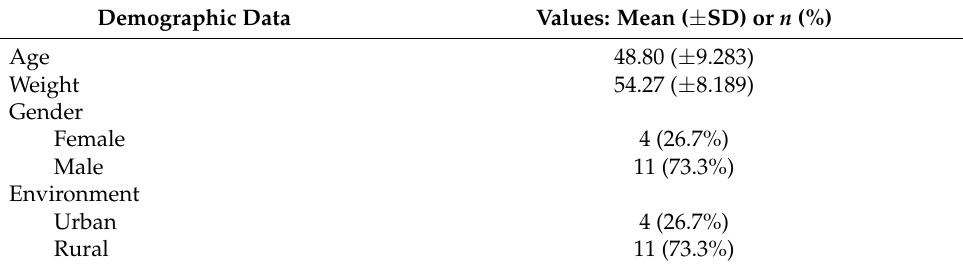
Table 1. Demographic characteristics of the patients.